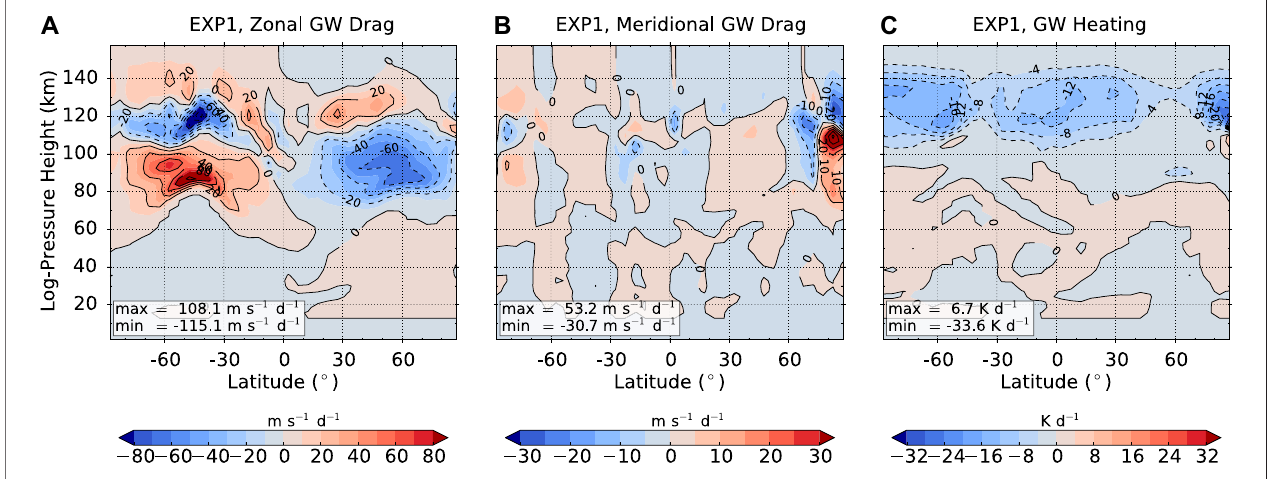
FIGURE3| Sameas Figure2 butforzonalGWdrag (A) ,meridionalGWdrag (B) ,andheatingduetoGWs (C) .Unitsin (A,B) m s − 1 d − 1 and (C) K d − 1